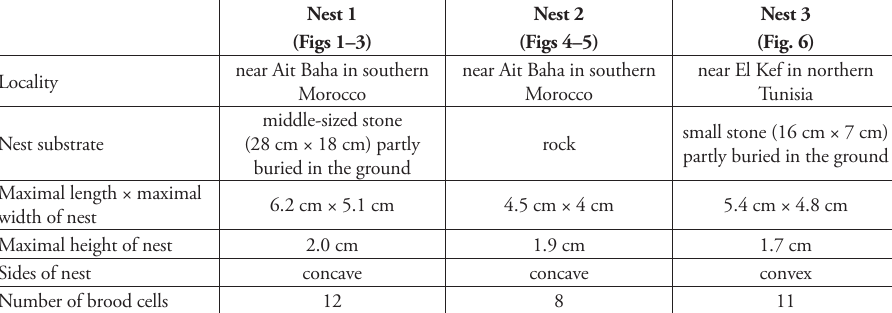
Table 1. Characteristics of three nests of Hoplitis mucida (Dours 1873) discovered in North